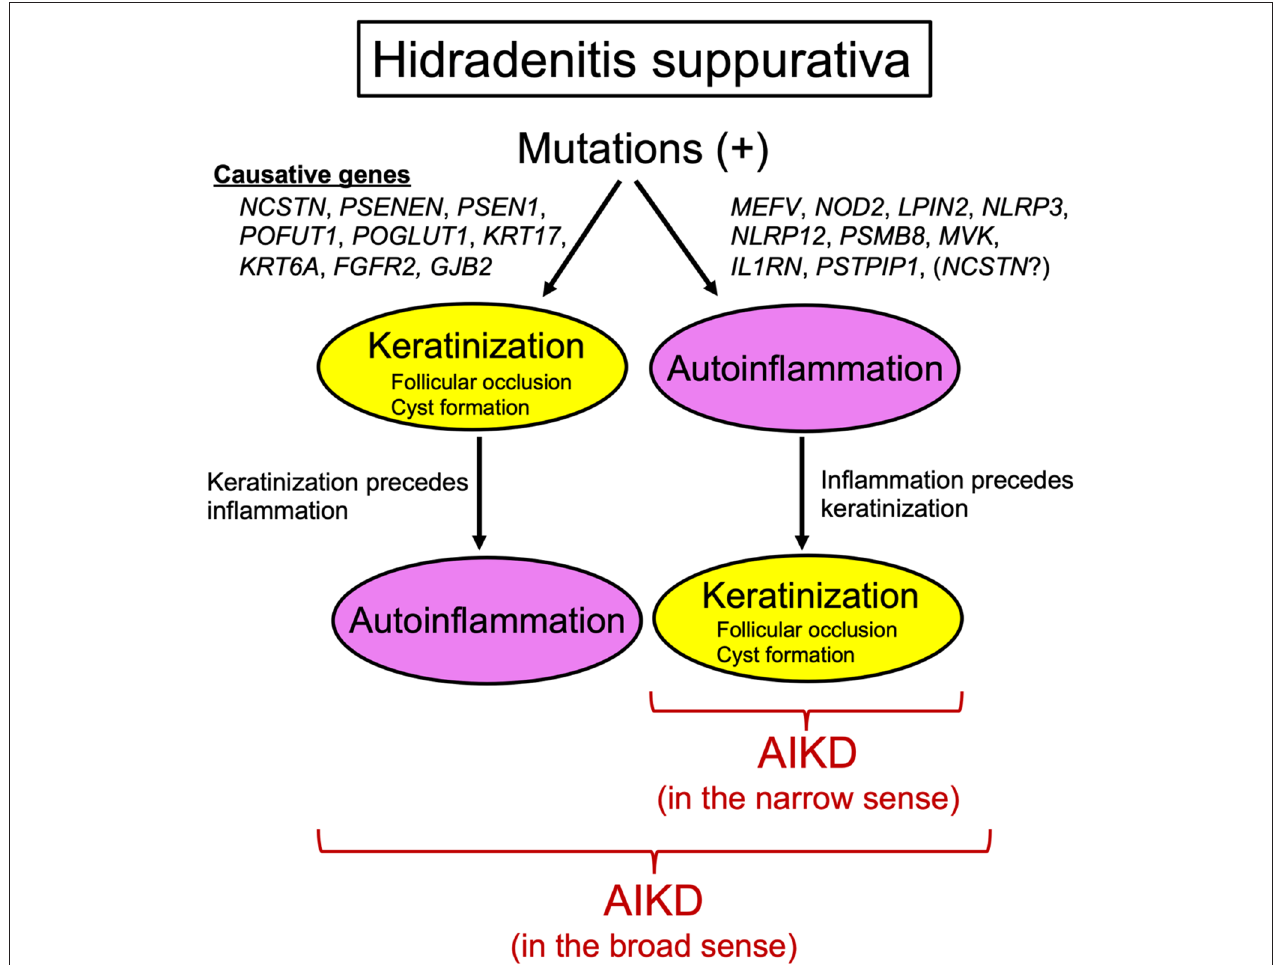
FIGURE 1 | Hidradenitis suppurativa and autoinflammatory keratinization disease. Genes responsible for hidradenitis suppurativa can be divided into two groups. One includes NCSTN , PSENEN , PSEN1 , POFUT1 , POGLUT1 , KRT17 , KRT6A , FGFR2 , and GJB2 , whose mutations result in autoinflammation preceded by